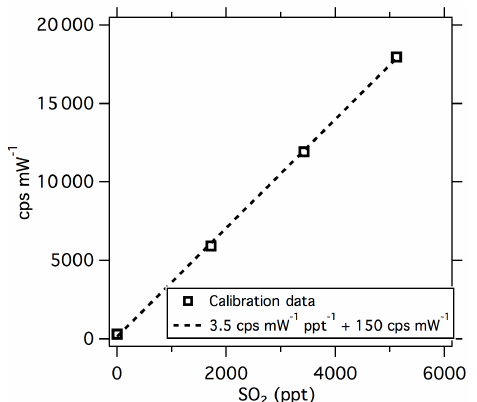
Figure 6. Example in-flight SO 2 calibration during the flight of 28 October 2015. Data shown are the linearized count rate divided by the measured laser power. The dashed line shows a fit to the four data points indicating the sensitivity of 3.5cpsmW − 1 ppt − 1 and background of 150cpsmW − 1